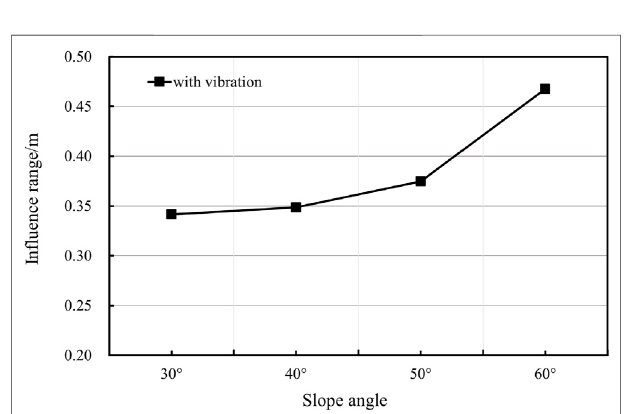
Frontiers in Physics |